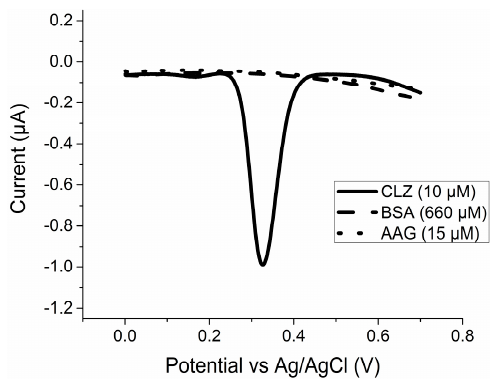
Figure 1. Differential pulse voltammograms for solutions containing BSA, AAG, or CLZ at 660, 15, and 10 µM,